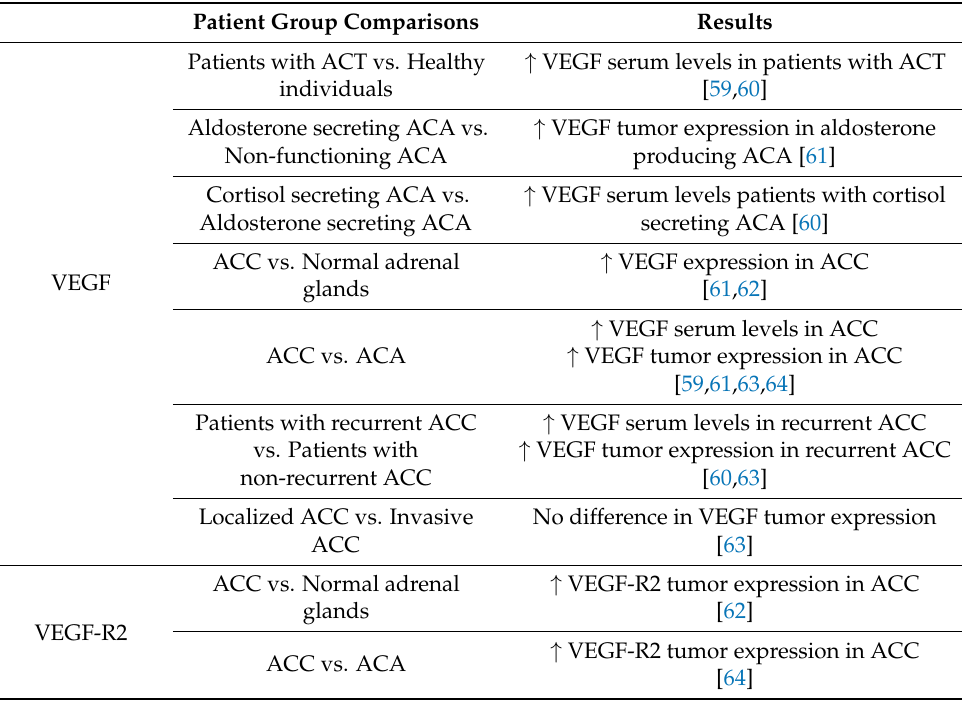
Table 1. VEGF pathway findings in adrenocortical